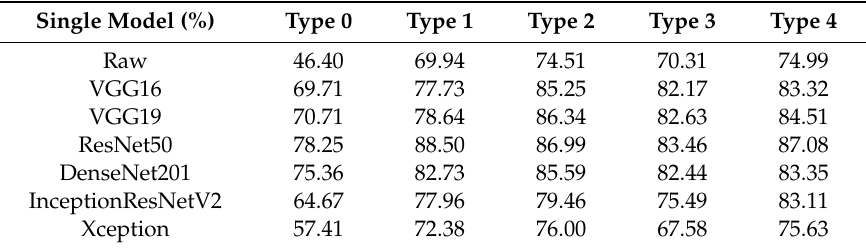
Table 6. Classification performance of the CNNs without data augmentation under transfer learning (4 classes).